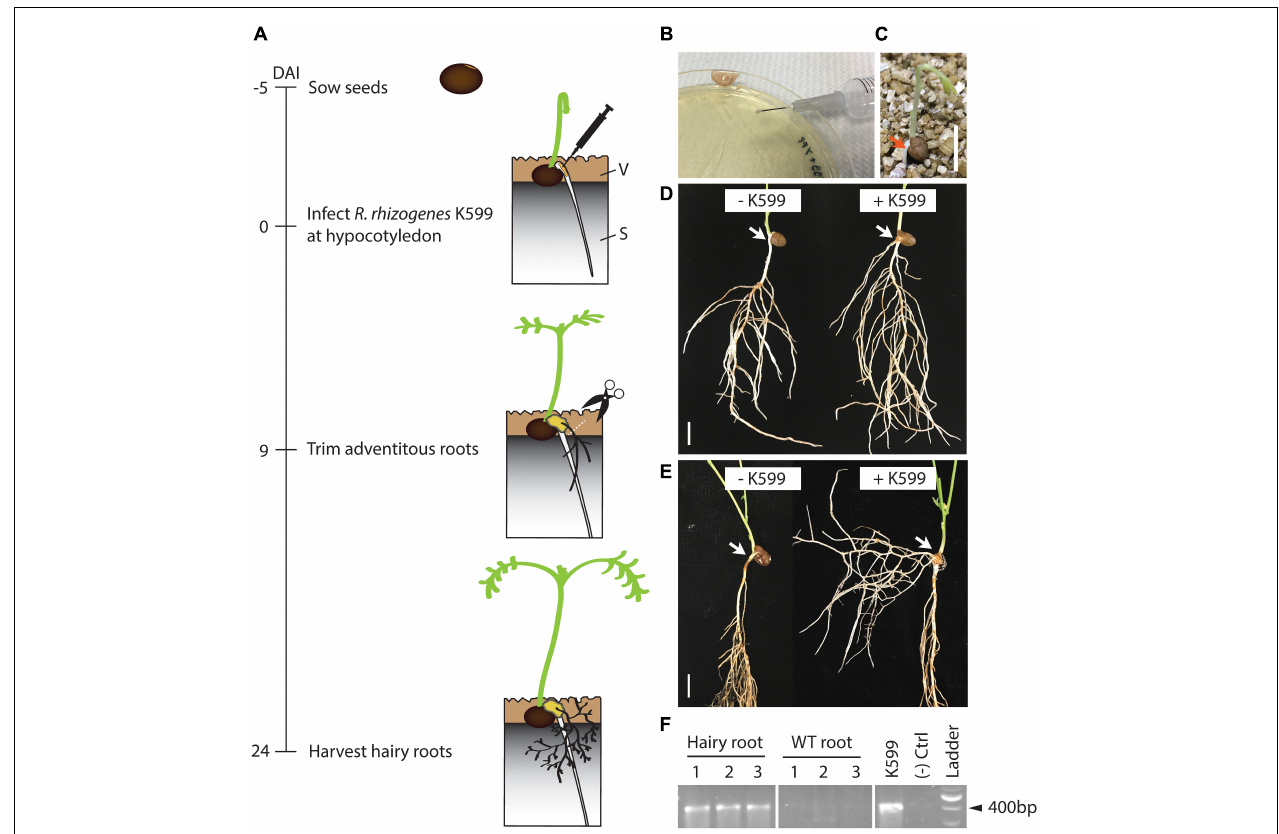
FIGURE 1 | Hairy root induction from vetch hypocotyl on soil by R. rhizogenes K599 using the stabbing method. (A) Timeline for hairy root induction on soil by R. rhizogenes . Vetch seeds were sown on top of a mixture of sand and cocopeat (1:1), and 1 cm of vermiculite was placed on top to cover the seeds (5 days before infection). On day 5, seedling hypocotyl regions were infected with R. rhizogenes (shown as day 0). Nine days after infection (DAI), adventitious roots were observed at the infected region and were trimmed off to promote the growth of hairy roots. Twenty-four DAI, hairy roots were observed. (B) R. rhizogenes were grown on an LB plate and scraped into a paste which was pushed into the hypocotyl region of plants by stabbing with a 27G 1/2 needle. (C) A 5-day old seedling with the red arrow showing the position to be inoculated using the stabbing method. (D) A 9 DAI control seedling that was stabbed with a needle containing no bacteria (–K599) and a seedling infected with K599 ( + K599). White arrow indicates inoculation site. No callus developed at the wounded site on the control plant. + K599 plant showed the formation of callus and adventitious roots at the wounded site. However, the adventitious roots had a wild type phenotype and were trimmed to promote hairy root development. (E) At 24 DAI, –K599 plant showed no callus or roots at the wounded sites. In. contrast + K599 plant showed the formation of hairy roots, which were highly branched and had lost plagiotropism. (F) The rolB gene was PCR amplified from DNA isolated from hairy roots but not from non-hairy roots from the same plants (three biological replicates, n = 3, are shown). DAI, day after the infection; V, vermiculite; S, sand and cocopeat (1:1, volume:volume). Scale bar = 1 cm.